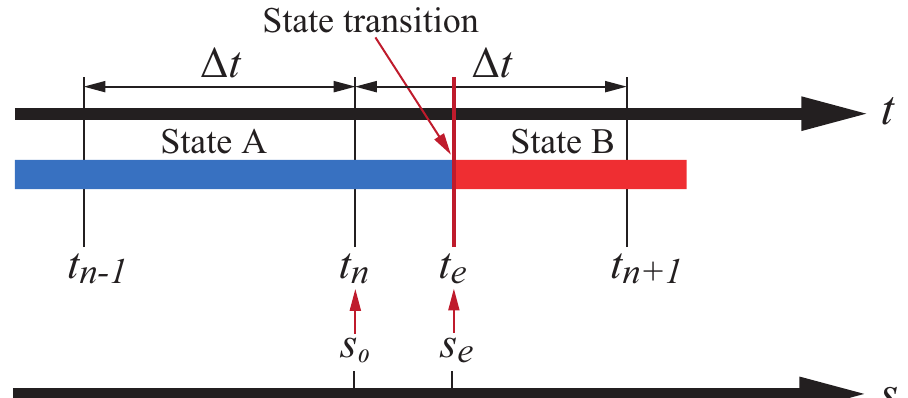
Figure 6. Process of slack variable